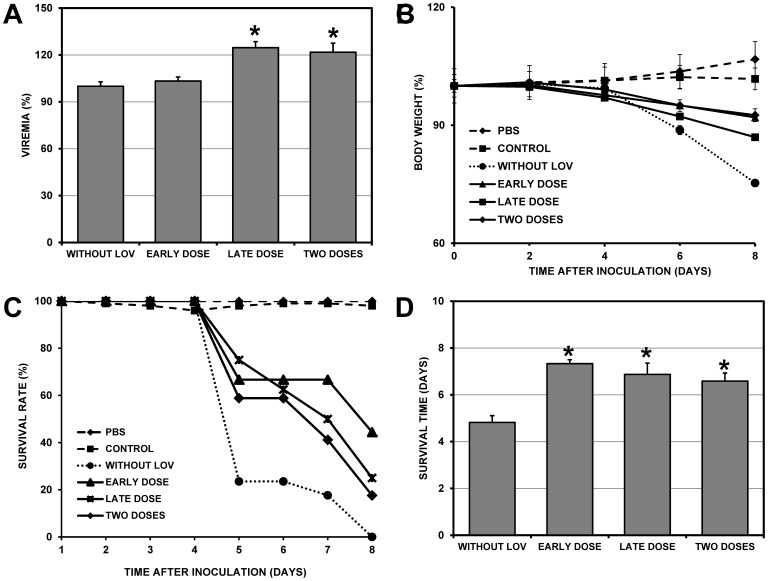
Effect of LOV treatment after viral inoculation (post-treatment).Groups of six mice were treated with LOV (200 mg/kg/day) orally with three treatment schemes: a single dose 24 hrs after inoculation (early dose), a single dose 48 hrs after inoculation (late dose) or two doses after inoculation (24 and 48 hrs). Inoculations were administered intraperitoneally with a viral dose of 1×106 PFU/ml. Three types of control groups were used. The “PBS” group consisted of mice that were not treated with LOV and were not infected, the “CONTROL” group consisted of mice that were treated with LOV but were not infected and the “CONTROL WITHOUT LOV” group consisted of mice that were not treated with LOV but were inoculated with DENV-2. The viremia and survival rates were compared between the control without LOV group and the treated groups (early, late and two doses groups). A. Plaque assay of infected VERO cells to quantify serum viremia at 3 dpi. Bars represent the standard error of the mean (SEM). B. Average body weight percentage, recorded every two days until the animals died or were sacrificed. C. Kaplan-Meier curve showing the survival rates of the untreated group and the three treated groups. D. Comparison of survival rates between the untreated group and the three treated groups. Asterisks in A and D indicate statistically significant differences between the treated LOV groups and the control without LOV group. In the groups treated with a single dose at 48 h after viral inoculation or with two doses (24 and 48 hpi), there was a significant increase in viremia. Moreover, the survival rates were increased in the three groups.